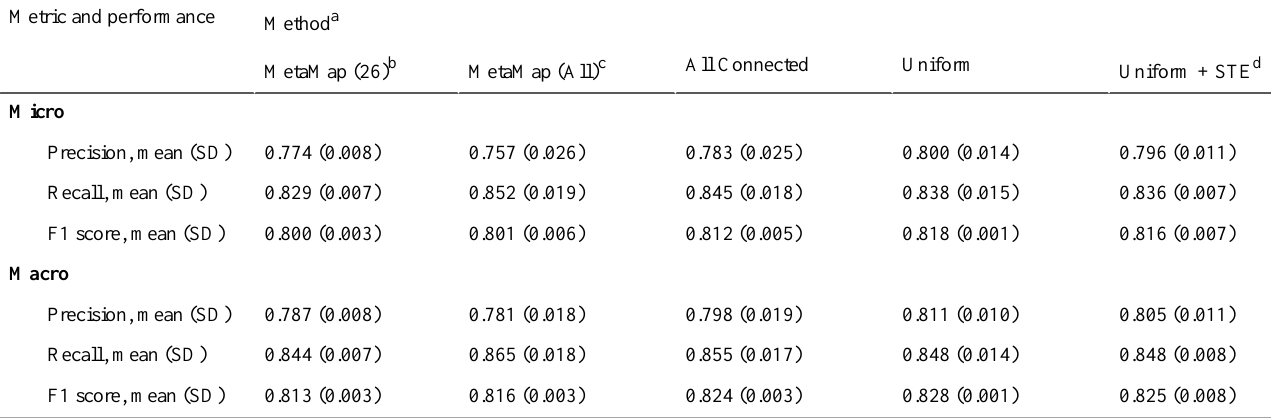
Table 3. AGGCN (Attention-guided graph convolutional network) performance with different methods. Method a Metric and